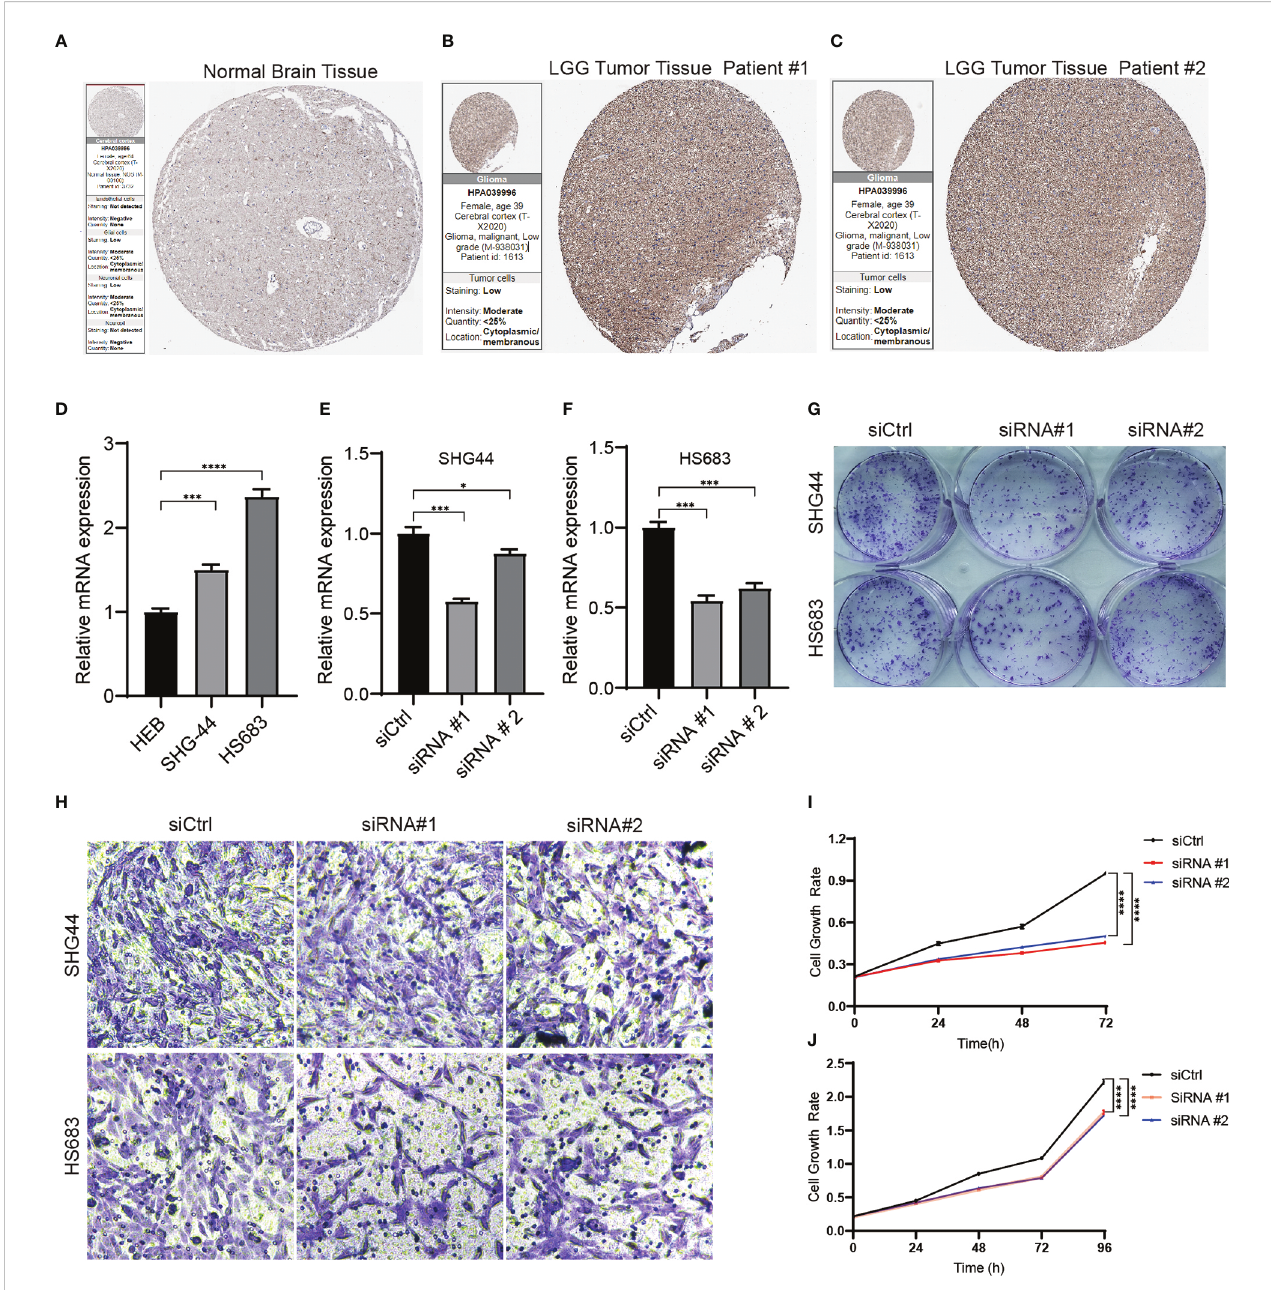
FIGURE 9 SLC10A7 was upregulated in LGG and was critical for the proliferation and migration of LGG cells. (A-C) SLC10A7 expression in normal brain tissue and LGG tumor tissue detected by immunochemistry. (D) The western blotting analysis con fi rmed that SLC10A7 was upregulated in LGG cell lines. (E, F) The ef fi cacy of SLC10A7 knockdown in two LGG cell lines. (G) The colony formation ability was detected using the crystal violet staining assay. (H) Cell migration ability of the LGG cell lines transferred with control or SLC10A7 siRNA was examined via the Transwell assay. (I, J) Cell proliferation of the SHG-44 cell line (I) and HS683 cell line (J) transferred with control or SLC10A7 siRNA was detected via the CCK-8 assay. *P <0.1, ***P < 0.001, ****P <